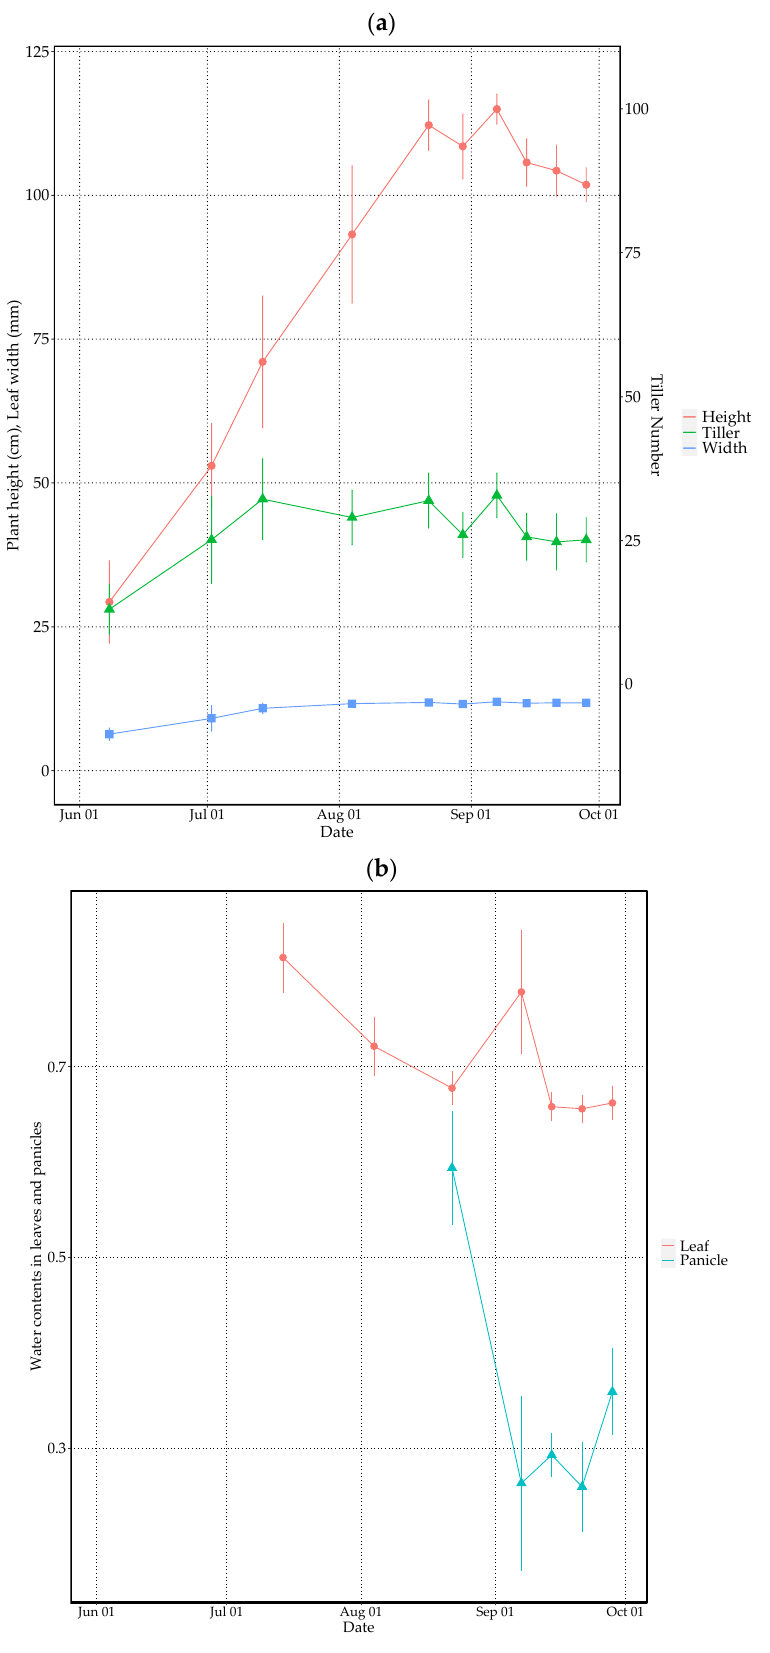
Figure 4. Field observation data for: ( a ) plant height (cm), maximum leaf width (mm), stem number per hill, and ( b ) water contents of leaves and panicles.